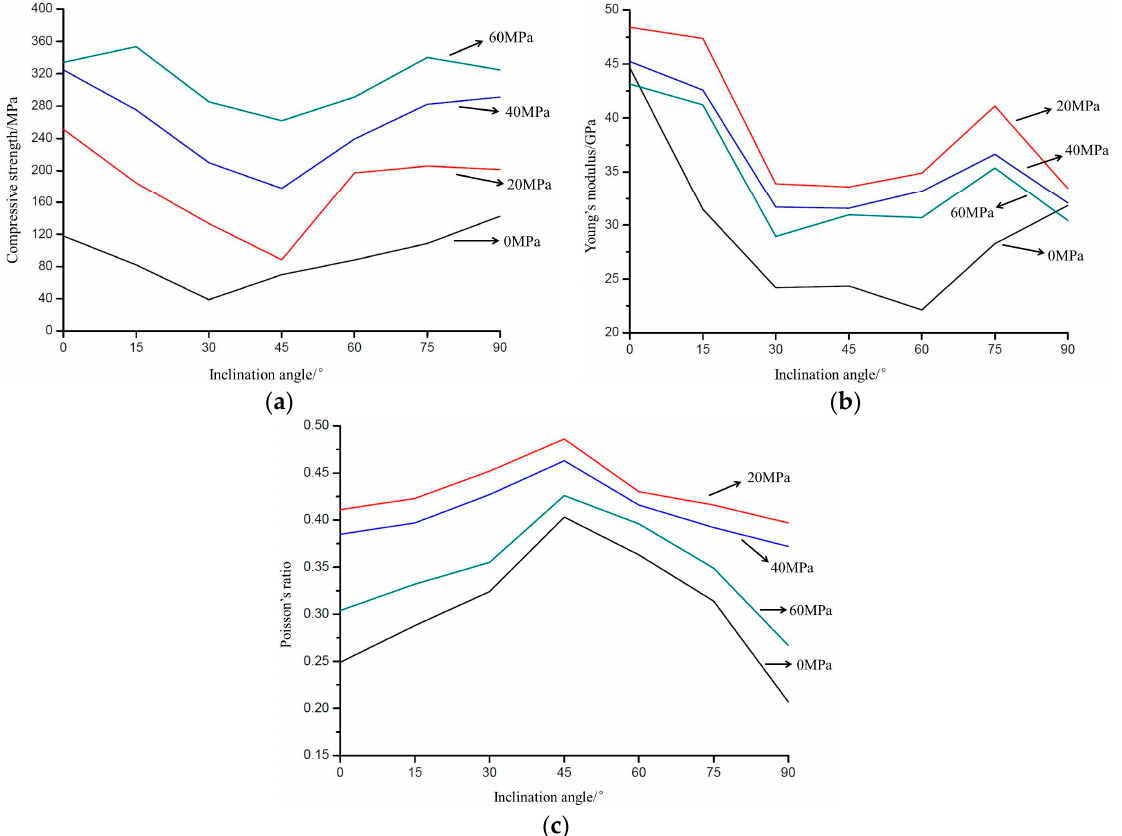
Figure 8. Relationships of ( a ) compressive strength, ( b ) Young’s modulus, and ( c ) Poison’s ratio of shale samples to inclination ( β ).